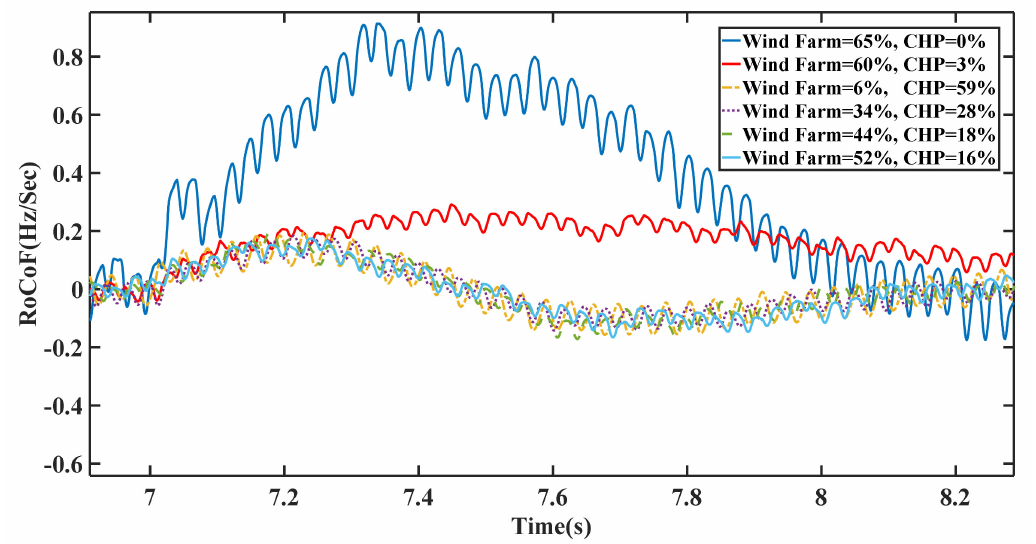
Figure 18. Rate of Change of Frequency (RoCoF) intended for various combinations of droop- and inverter-based structures during the –10% load step